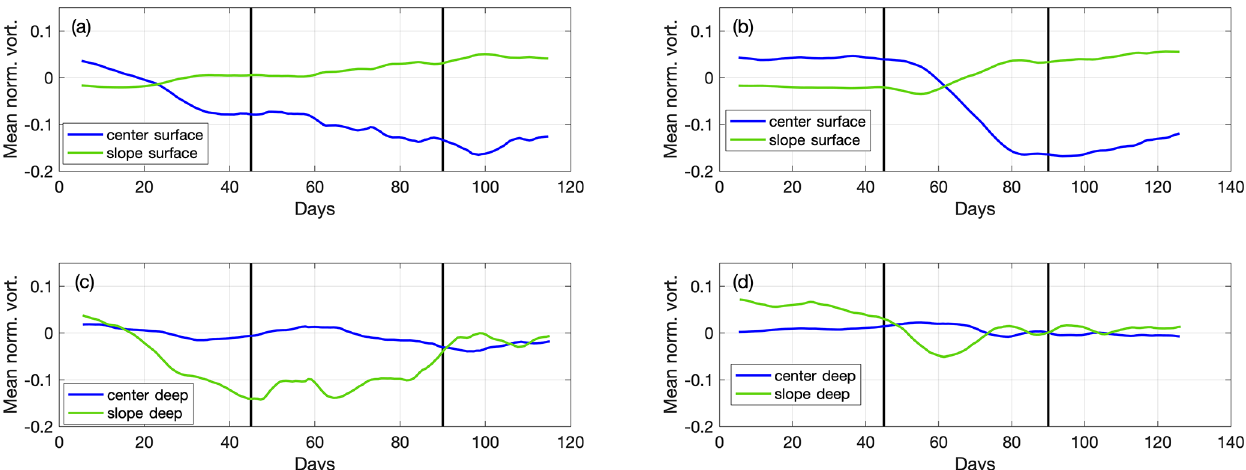
Figure 5. Evolution of the average vorticity normalized by the Coriolis parameter for EXP24 (a, c) and EXP27 (b, d) . Vorticity curves are smoothed with a moving average of 15 points. In the legends, “center” refers to the central area of the tank (upper or lower layer), and “slope” refers to the slope area (upper or lower layer). “Days” stand for rotation